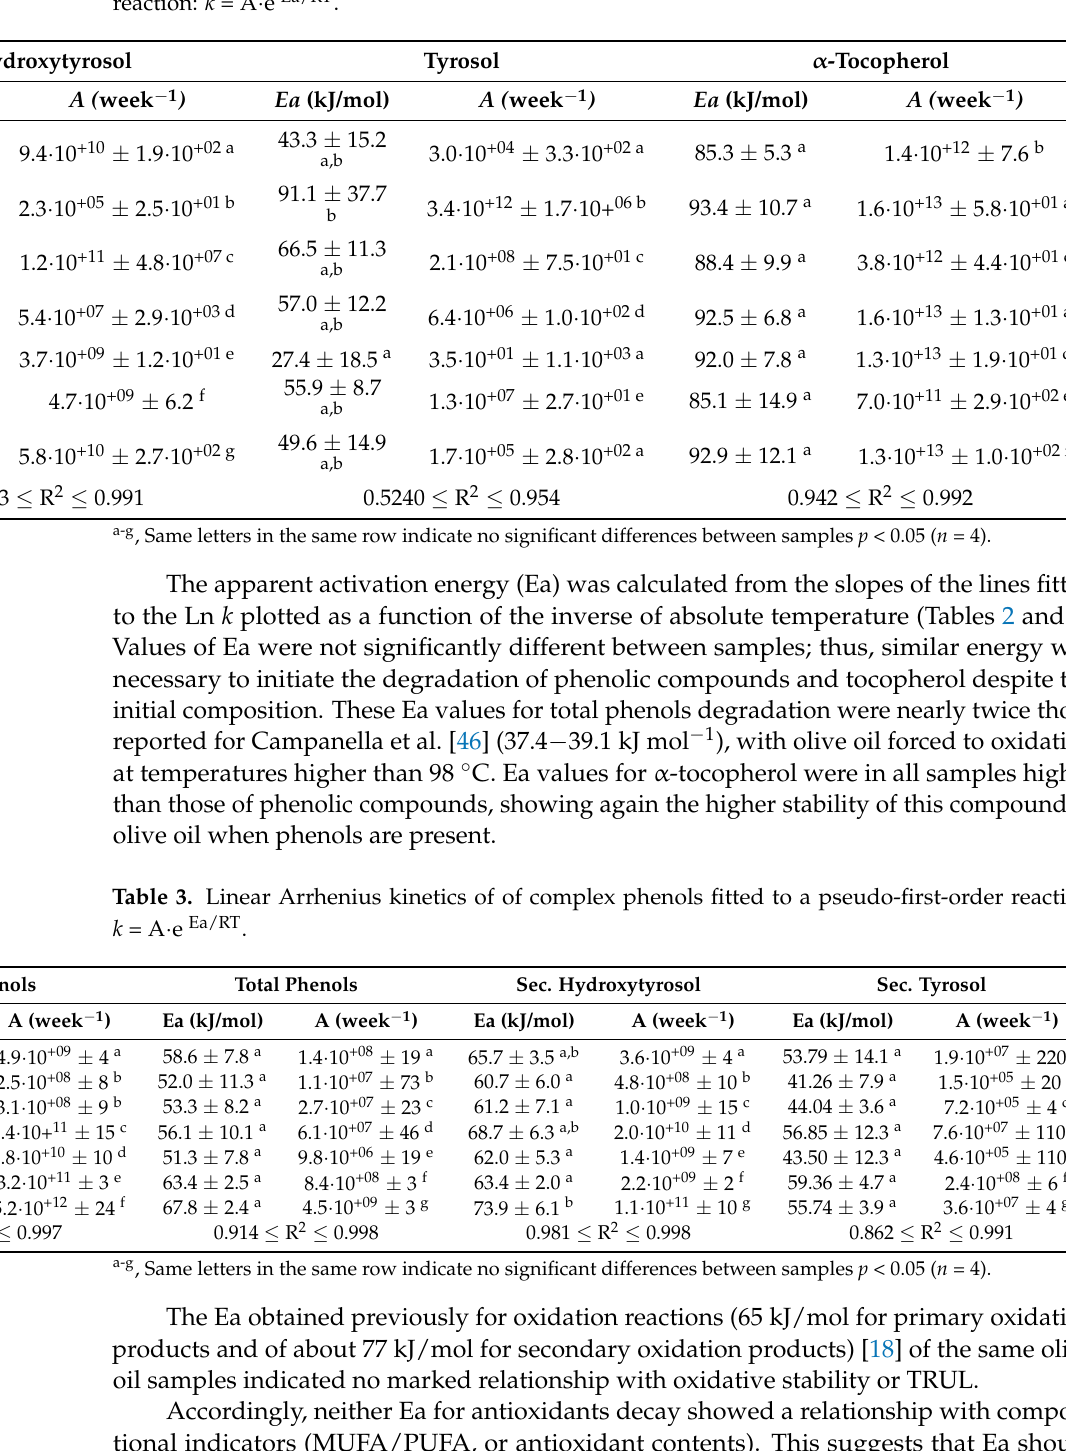
Table 2. Linear Arrhenius kinetics of simple phenols and α -tocopherol fitted to a pseudo-zero-order reaction: k = A · e Ea/RT .